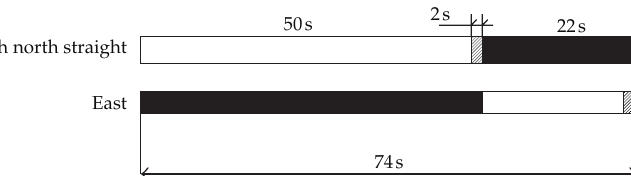
Figure 7: Distribution diagram of signal timing of T-shaped intersection A.